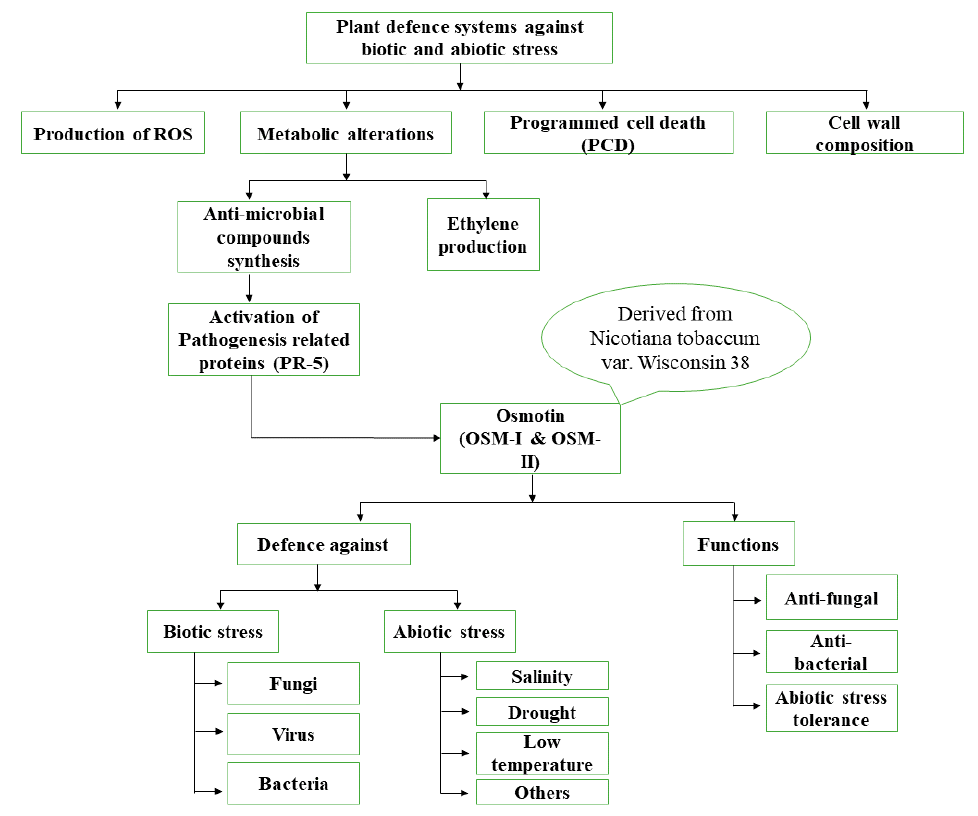
Figure 1. Schematic representation of the role of osmotin in plant defense mechanisms.